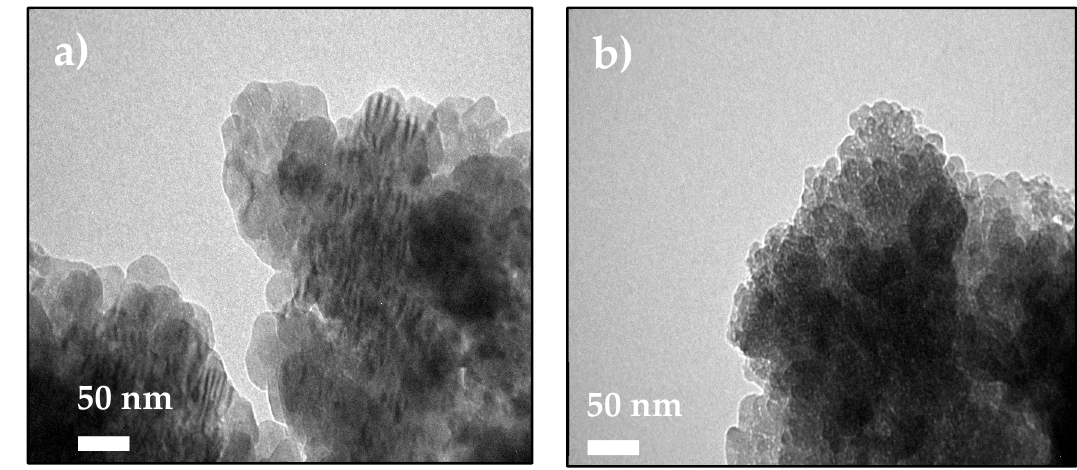
Figure 6. TEM micrographs of ACC proto-structures using ( a ) MWCNT and ( b ) MWCNT-Ox as additive for PNC assays at pH 9.0.